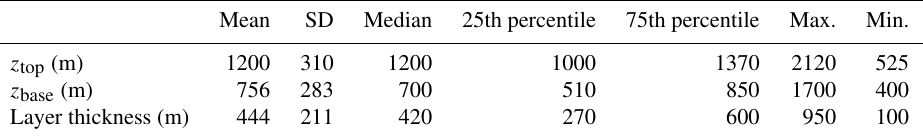
Table 3. Statistics of cloud base and cloud top altitudes along with cloud layer thickness obtained from the 71 profiles sampled in MPCs. Mean SD Median 25th percentile 75th percentile Max. Min.